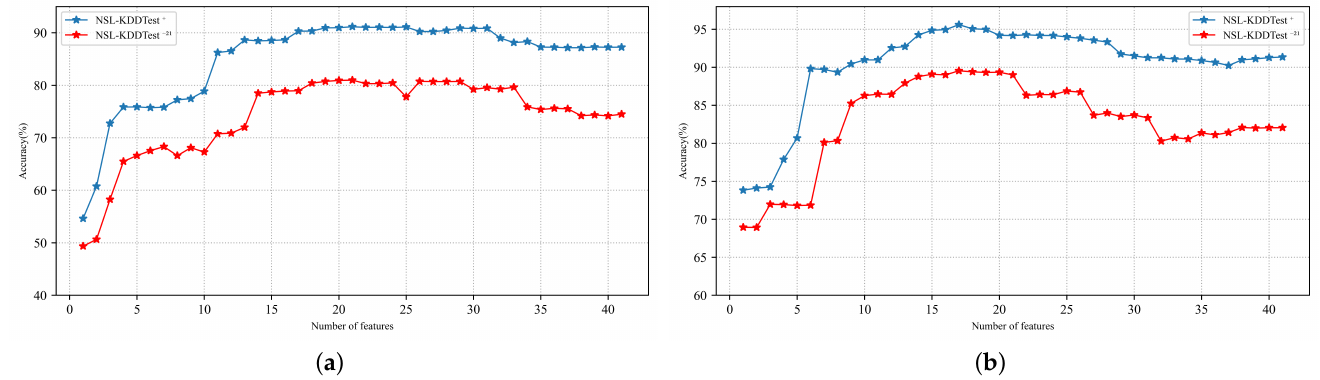
Figure 6. Performance results of different subsets of features on NSL-KDDTest + and NSL-KDDTest − 21 . ( a ) Performance of different subsets on NSL-KDDTest + ; ( b ) performance of different subsets on NSL-KDDTest − 21